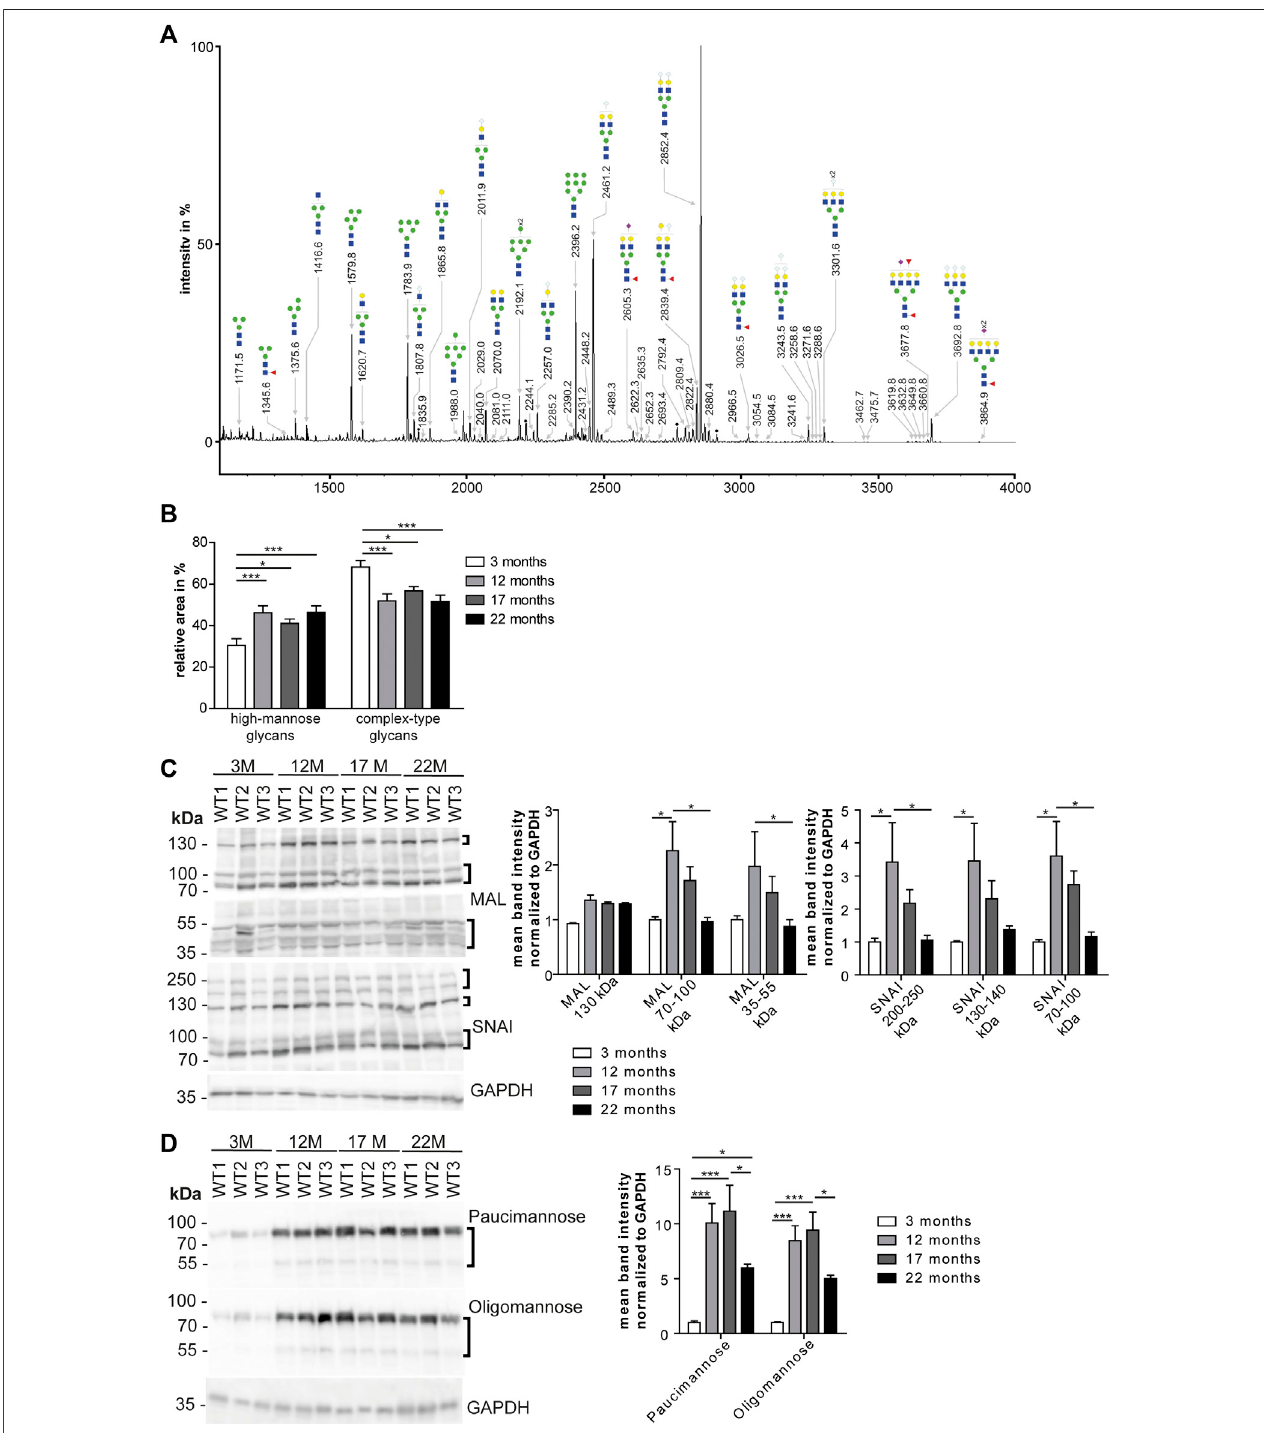
FIGURE2| Agedependentchangesofhighmannose N -glycansintheheart. (A) RepresentativeMALDI-TOFspectraofpermethylated N -glycansmeasuredinthe positive ionization mode. All molecular ions are present in sodiated form [M + Na] + . Green circle: Man, yellow circle: Gal; blue square: GlcNAc, white diamond: NeuGc, violet diamond: NeuAc, red triangle: Fuc, black asterisk: non-carbohydrate contamination. (B) Relative intensities of the MALDI-TOF spectra from permethylated N -glycans released from mouse heart tissues ( n (cid:2) 6 mice per age; 1-way ANOVA with Bonferroni posthoc test). Relative intensities of individual spectra are presented in Supplementary Table S1 . (C) Western Blots probed with lectins recognizing neuraminic acid. For quanti fi cation GAPDH served as loading control ( n (cid:2) 6 mice per age; 2-way ANOVA with Bonferroni posthoc test). MAL: Neu5(Ac/Gc)- α (2,3)-Gal- β (1,4)-GlcNAc-R, SNA: Neu5(Ac/Gc)- α (2,6)-Gal- β (1,4)-GlcNAc-R. (D)